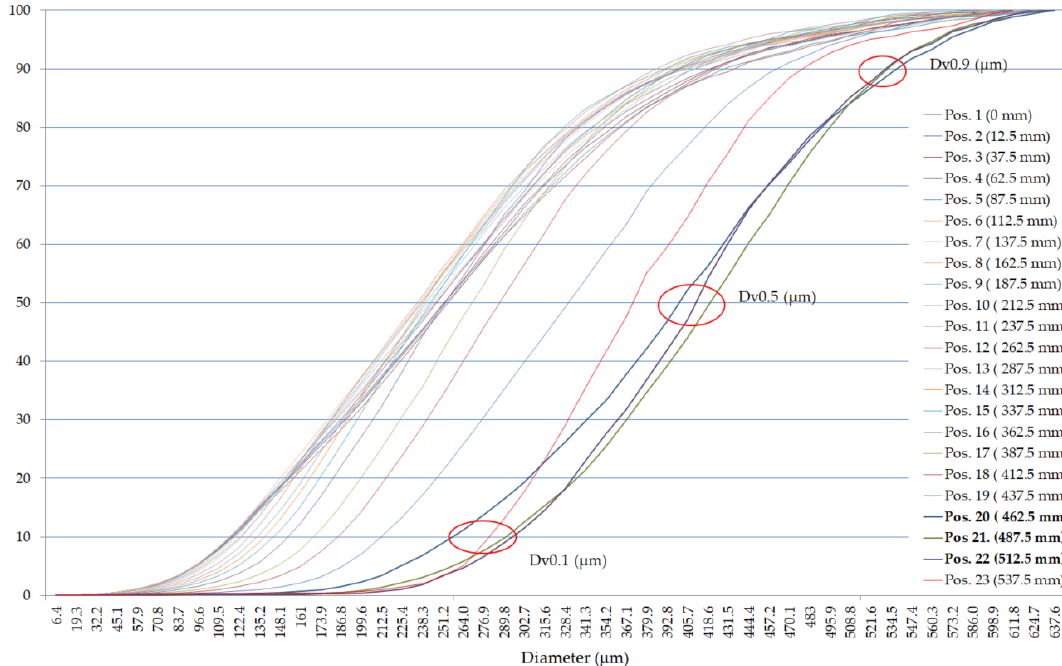
Figure 7. Cumulative percentage volumes for the right side of nozzle number 2.